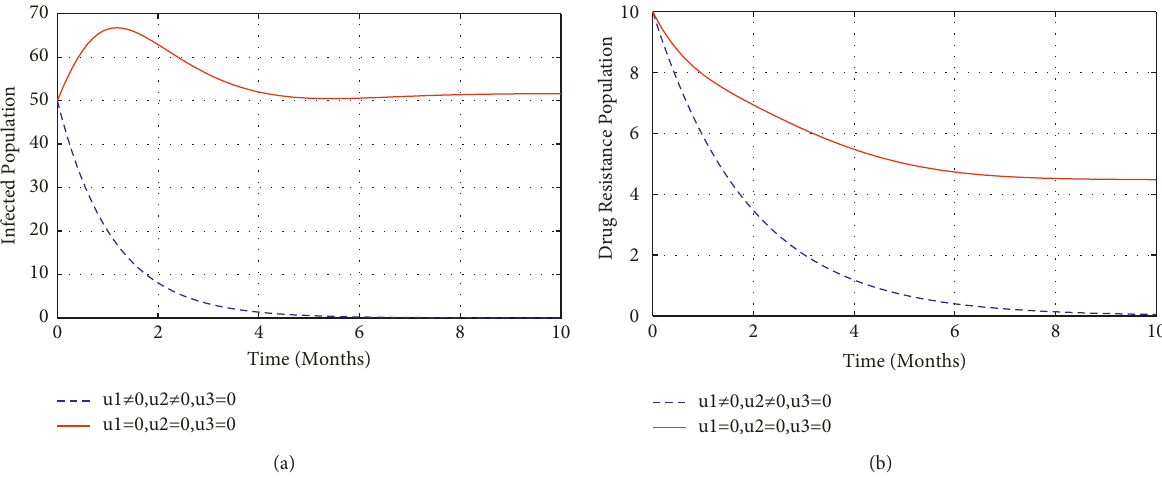
Figure 5: Impact of education and treatment of infectious population on infectious and drug resistance populations.